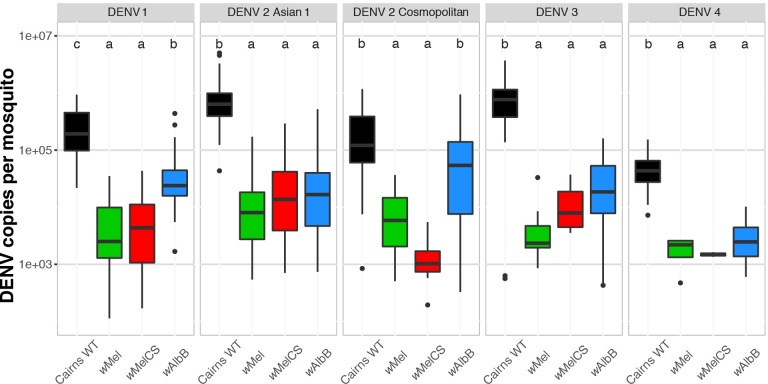
wMel, wMelCS, and wAlbB all provide viral blocking following intrathoracic DENV infection.DENV-1-4 were intrathoracically injected in 6–7 day-old wMel-, wMelCS-, or wAlbB-infected mosquitoes as well as wildtype (WT) controls. After a 7-day incubation, RNA was extracted and DENV genomic copies quantified by qRT-PCR. Data are shown as the median DENV genomic copies per mosquito (thick line) ± interquartile ranges (box), extended by the whiskers indicating 1.5× the interquartile range, with dots indicating outliers. N for strain-virus combination are shown in Table 1. Using a Kruskal-Wallis test with Dunn’s correction, the letters indicate statistically significant differences between groups.